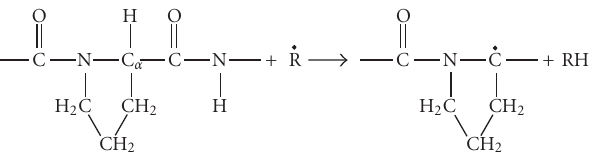
Figure 5: The melting curves of irradiated collagen in the presence of ascorbic acid, the ascorbic acid concentration is (a) 0 . 6, (b) 0 . 8, (c) 2 . 4 mg/ml, accordingly (the collagen concentration in solution is 0 . 35 mg/ml. Duration of the irradiation is 5min).